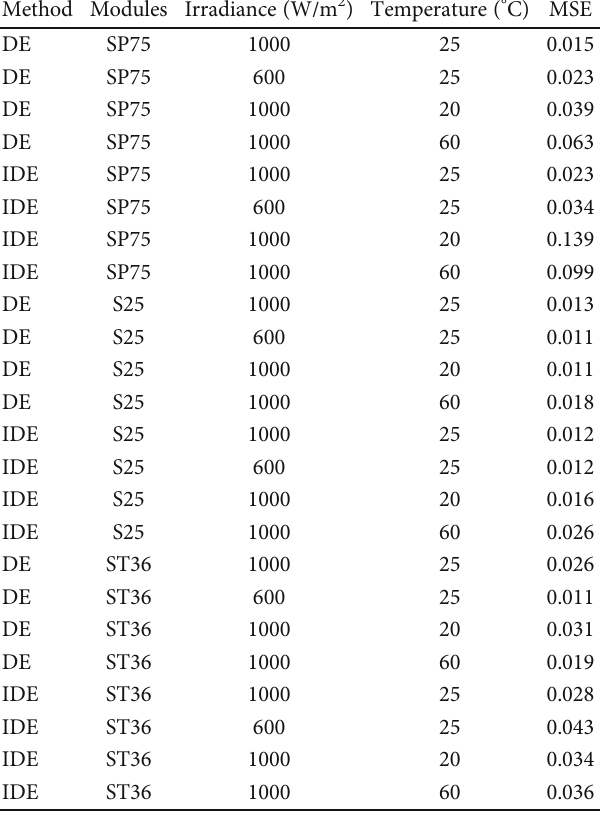
Table 6: Mean absolute error at di ff erent environmental conditions for three kinds of PV module.